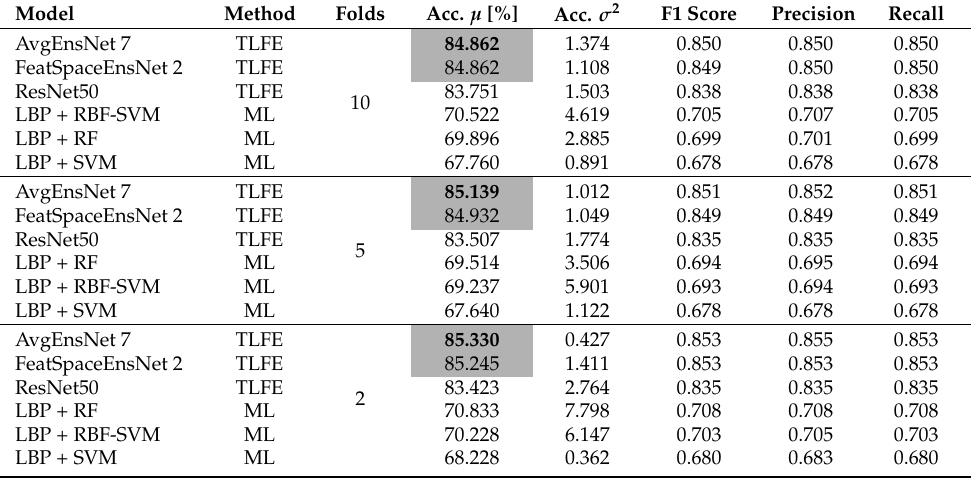
Table 7. Performance of best performing models under different cross-validation folds.